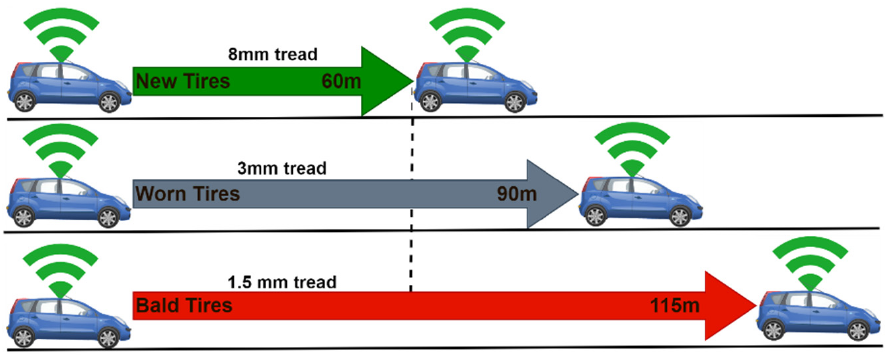
Figure 8. Effect of the tire state on the braking distance.